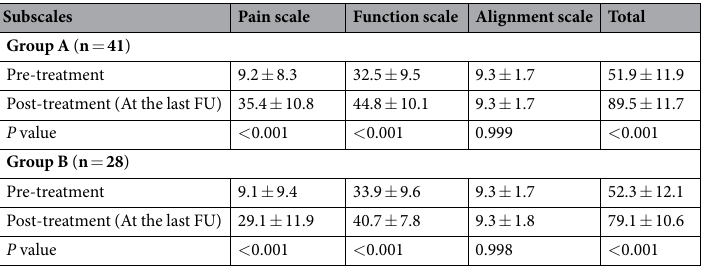
Table 2. The results of the subscales of American Orthopaedic Foot and Ankle Society (AOFAS) score. Note: FU: